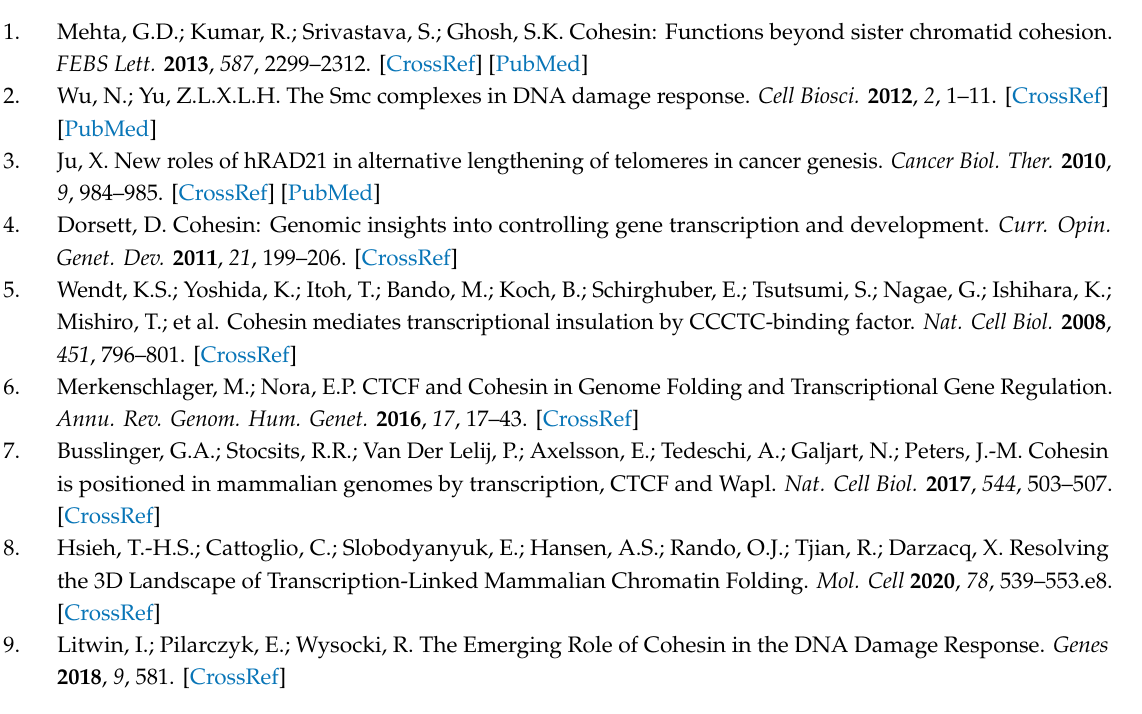
Figure S1: Unedited dot blots used in Figures 1D and 2H,J